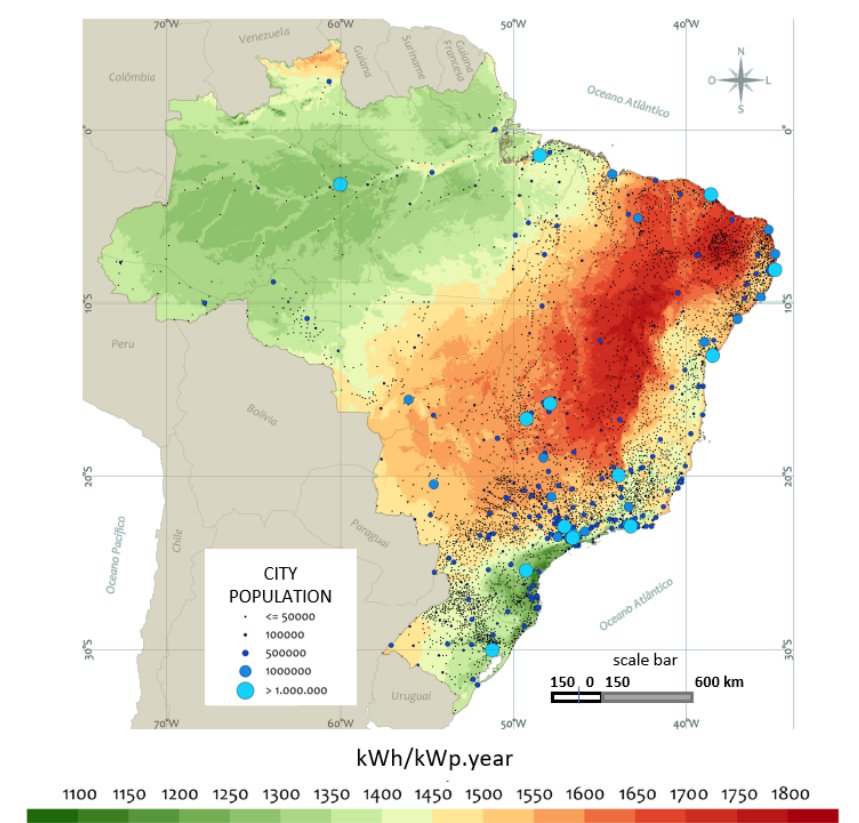
Figure 1. Photovoltaic power generation potential in Brazil. The size of the blue circles represents the number of inhabitants in each Brazilian city. Adapted from